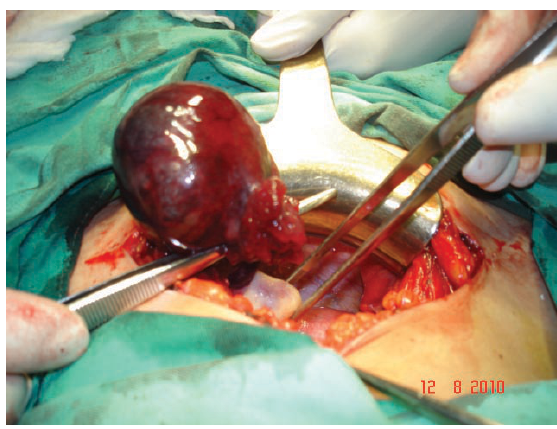
Figure 1. Left fallopian tube twisted threefold on its vascular pedicle.